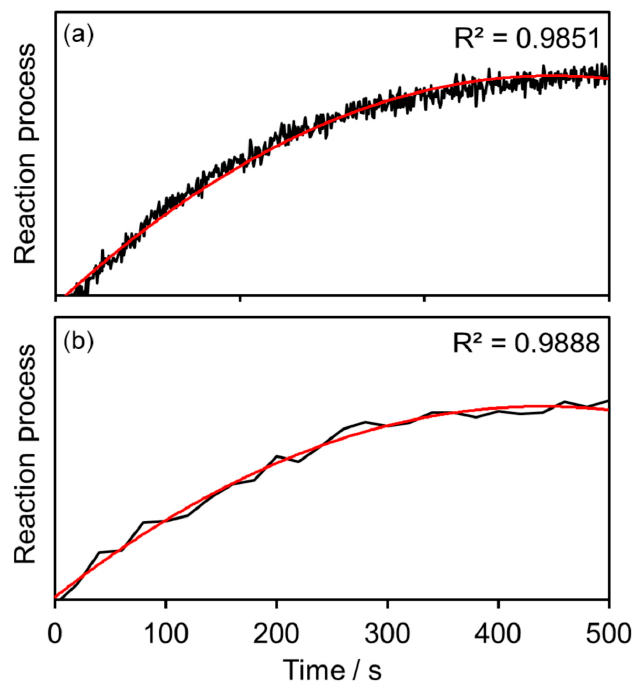
Figure 11. Comparison of ( a ) photometric and ( b ) spectroscopic measurements of CO 2 binding to amine [18].